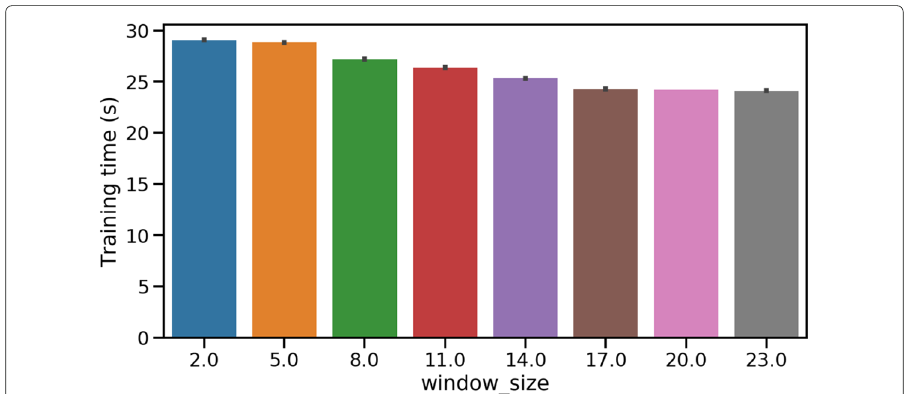
Fig. 14 Training time for each window size. This time corresponds to the training of the Self-Organizing Map and the clustering